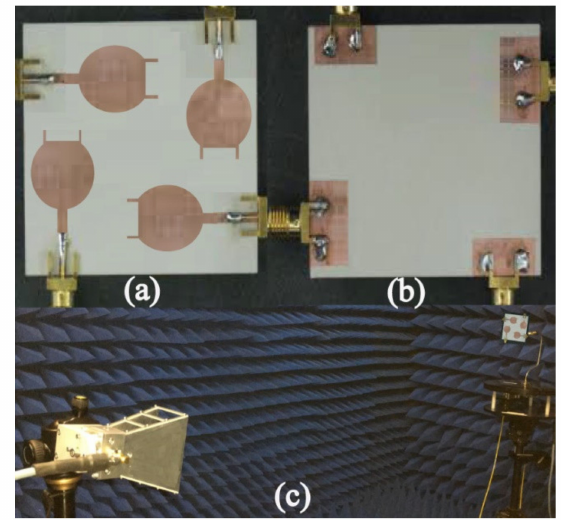
Figure 5. Snapshot of the proposed UWB MIMO antenna. ( a ) Radiating Patch side, ( b ) Partial Ground side, ( c ) Measurement